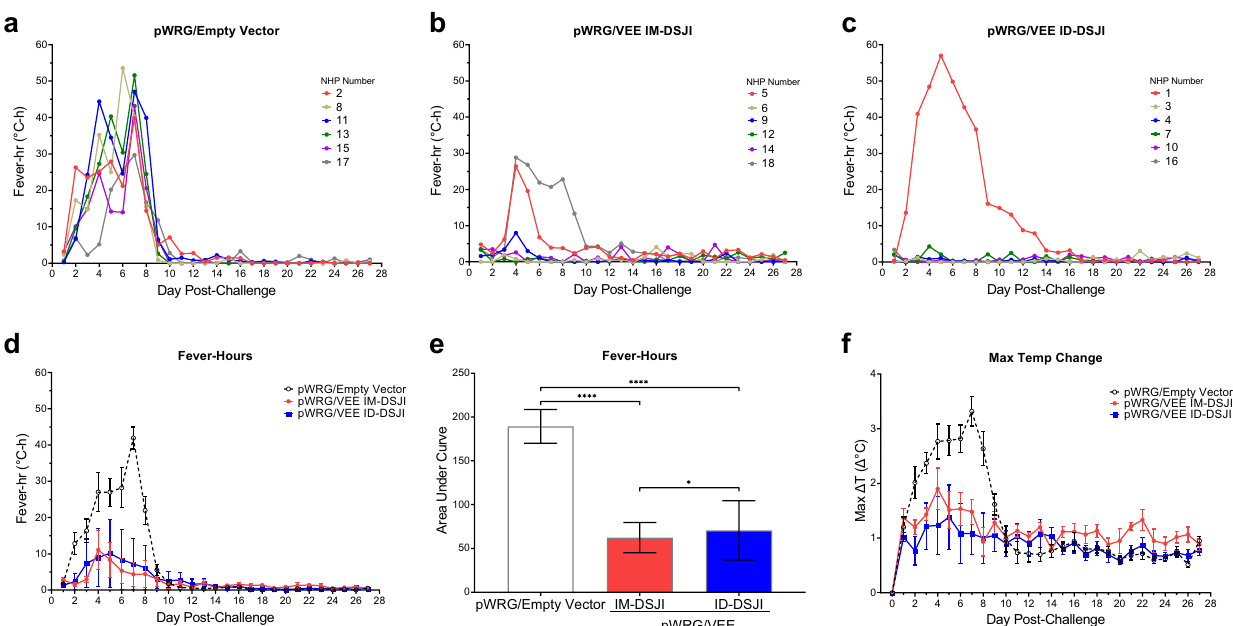
Fig. 5 Fever responses in nonhuman primates (NHPs) following VEEV aerosol challenge. Fever-hours for individual animals in the ( a ) pWRG/empty vector ( b ) pWRG/VEE IM-DSJI and ( c ) pWRG/VEE ID-DSJI groups. Fever-hours are the sum of the signi fi cant temperature elevations (de fi ned as >3 SD above baseline) in a 24 h period. The group means ± SEM and area under the curve (AUC) are presented in ( d ) and ( e ), respectively. f Maximum temperature elevation above baseline in a 24 h period. Data are presented as mean ± SEM. p values were determined using a one-way ANOVA with Tukey ’ s multiple comparison test. * p < 0.05, **** p <